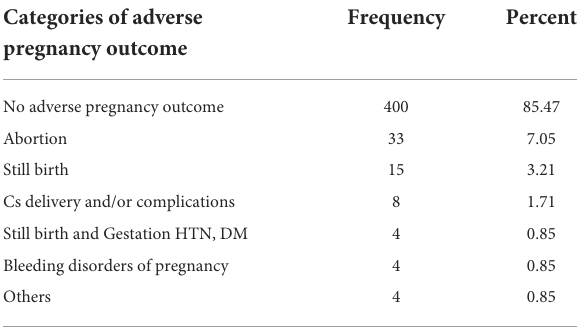
TABLE 3 Summary of lifetime adverse pregnancy outcome, in Northwest, Ethiopia, 2021 ( n =